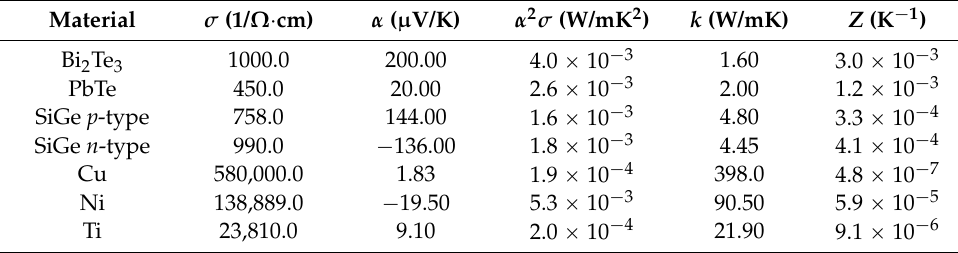
Table 2. The thermoelectric parameters of selected semiconductors and metals